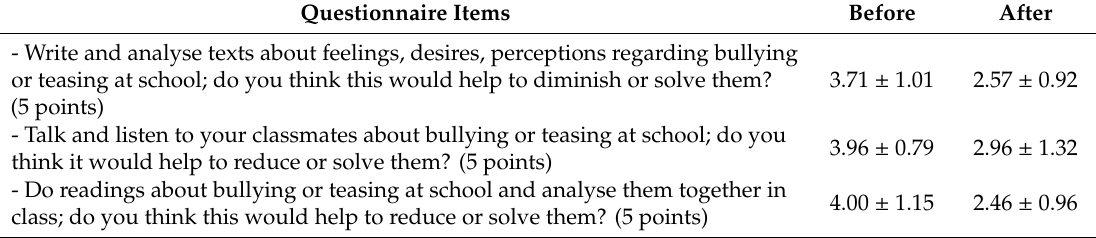
Table 4. Communication skills